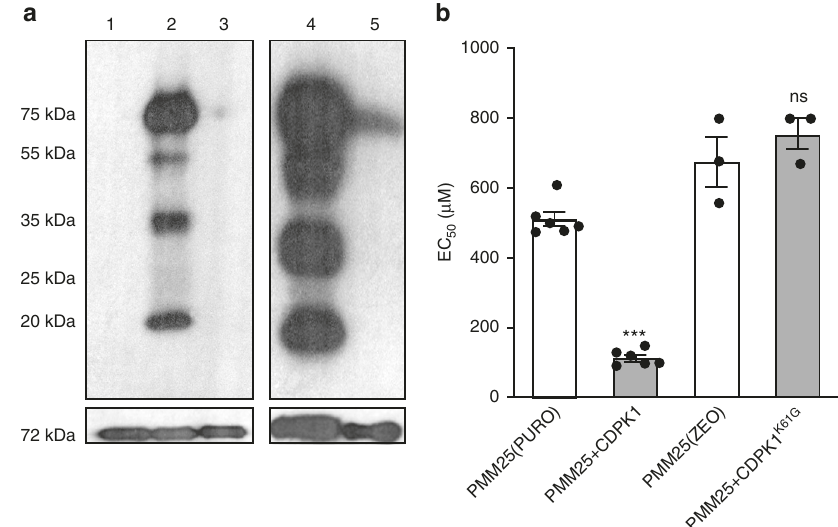
Fig. 2 Kinase activity of the L. infantum CDPK1. a Phosphorylation of proteins immunoprecipitated with CDPK1-HA as determined by autoradiography after in vitro kinase assay followed by electrophoresis in 12% SDS – PAGE. Assays were performed without γ -P 32 -ATP (lane 1), with 2.5 μ Ci γ -P 32 -ATP (2) and with γ -P 32 -ATP in presence of excess of non-radioactive ATP (3). In an independent set of experiments, assays were performed with immunoprecipitated CDPK1-HA (4) and CDPK1 K61G -HA (5) both using 2.5 µ Ci of γ -P 32 -ATP. Lower panels depict the amount of immunoprecipitated CDPK1 involved in each reaction as observed by Western blotting of the immunoprecipitated complex using mouse anti-HA IgG. b Impact of the CDPK1 K61G mutation on PMM resistance. EC 50 values were determined by dose responsive curves against PMM. The wild-type and K61G CDPK1 versions were cloned in PURO or ZEO vectors respectively, thus explaining two PMM25 controls transfected with the empty PURO and ZEO vectors. Data are mean ± SEM for n = 6 (PMM25(PURO); PMM25 + CDKP1) or n = 3 (PMM25(ZEO); PMM25 + CDPK1 K61G ) biologically independent replicates. Statistical analyses were performed using unpaired two-tailed t -tests. *** P < 0.001. ns, not signi fi cant. Source data are provided as a Source Data fi